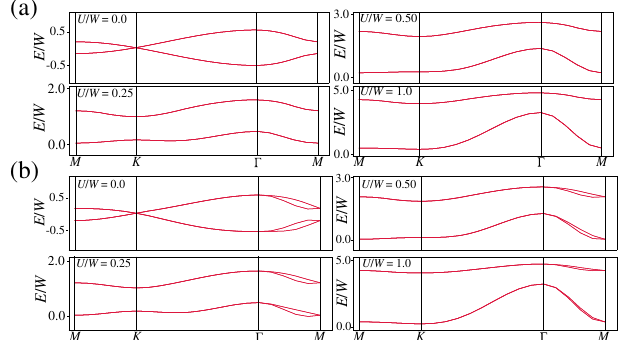
FIG. 8. QVH insulator and band structures with longer hop- pings. Band structures at various interaction strengths with α ¼ 0 . 45 and fifth nearest-neighbor hopping (a) t (b) t 2 =t ¼ 0 . 025 (cid:3) 0 . 1 i . The top-left plots in (a,b) display the bare kinetic bands in the absence of any interactions. The Dirac cones at K are evident and confirm the semimetallic phase of the bare bands in both cases. The remaining six plots present the renormalized band structures with increasing U . It is evident that the only effect of including the fifth nearest-neighbor hopping is an emergent splitting along Γ − M . This splitting decreases with increasing U=W .